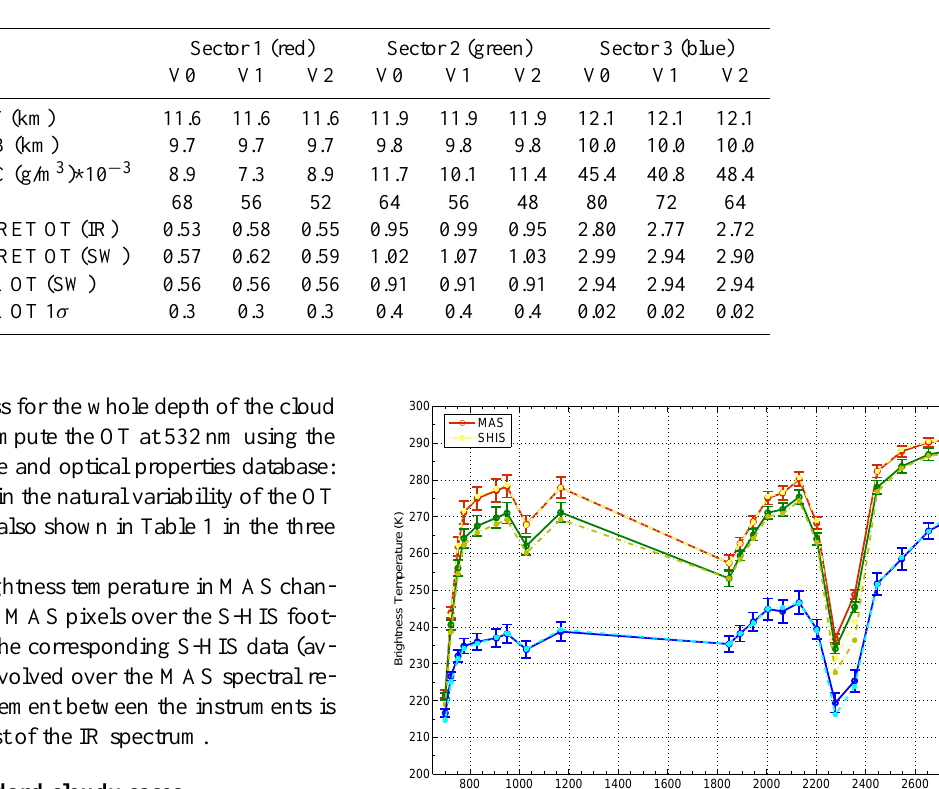
Table 1. Characteristics of the 3 cloudy sectors used for the comparisons. CLT and CLB are cloud top and bottom height obtained rom CPL; RT-RET OT (IR) and D e , hence IWC, are retrieved by RT-RET averaged in each sector; CPL OT is measured by CPL at 532nm and CPL OT 1 σ is one standard deviation of measured CPL OT in each sector.